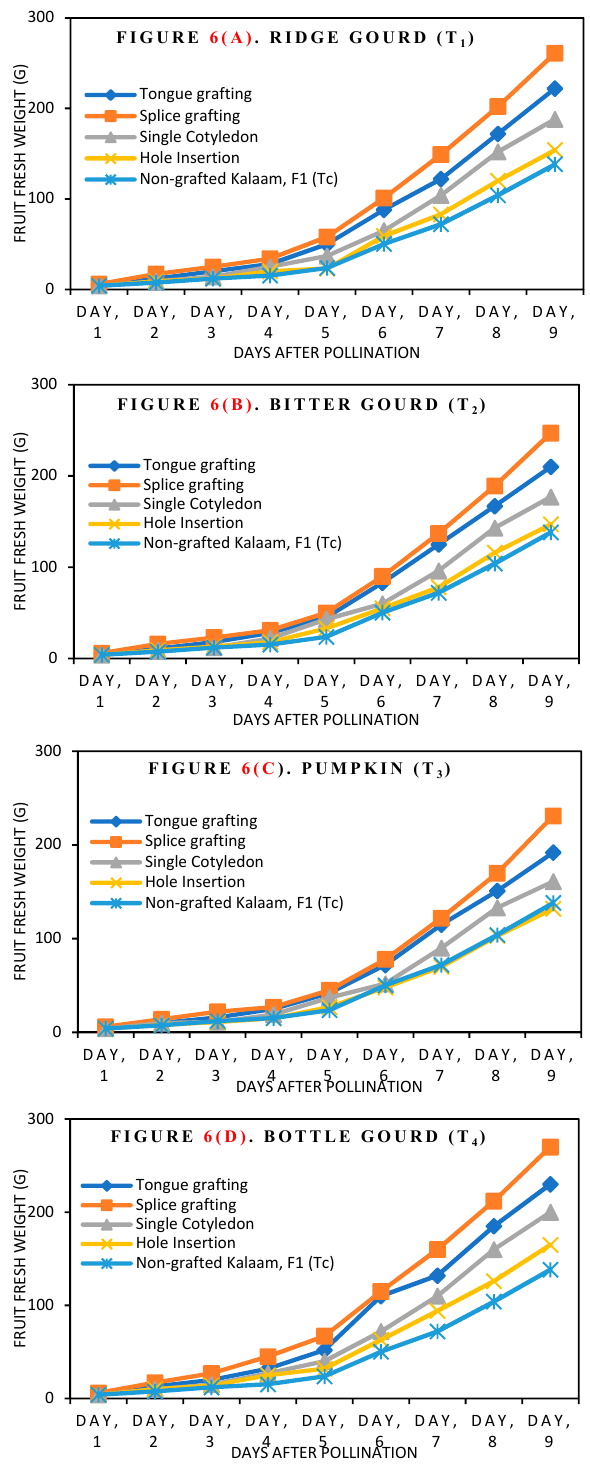
Figure 6. ( A – D ). E ff ect of scion / rootstocks combinations (grafting) on fresh weight of Cucumber Figure 6. (A, B, C, D). Effect of scion/rootstocks combinations (grafting) on fresh weight of Cucumber fruit.